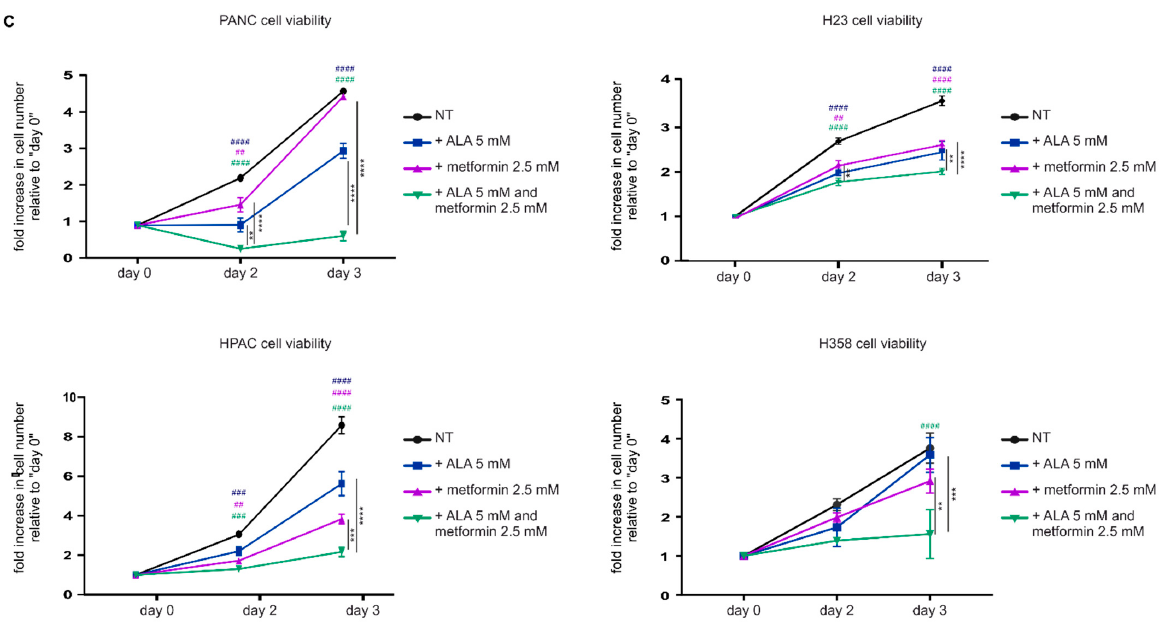
Figure 3. The down-modulation of the heme synthesis-export system sensitizes pancreatic and lung cancer cells to metformin. ( A ) Western blot analysis of FLVCR1a expression in PANC (on the left ) and H23 (on the right ) cells. Vinculin expression is used as a loading control. Cells in which the expression of FLVCR1a was down-regulated using a specific shRNA are compared to cells expressing a scrambled shRNA. A representative blot is shown. For statistical analyses a Student t - test was used. Densitometry shows mean ± SEM, n = 2 biological replicates, * p < 0.05. ( B ) Cell viability of PANC (on the left ) and H23 (on the right ) cells untreated (NT) or treated with 2.5 mM metformin, measured after two days of drug exposure without medium refresh. Cells in which FLVCR1a expression was down-modulated using a specific shRNA are compared to cells expressing a scramble shRNA. Cell viability is measured as a fold increase over an untreated calibrator sample and expressed relative to day 0. For statistical analyses, a two-way analysis of variance was performed, followed by the Bonferroni correction for multiple groups comparisons. Values represent mean ± SEM, n = 4 biological replicates, ** p < 0.01, *** p < 0.001. ( C ) Cell viability of PANC, HPAC H23 and H358 cells measured at different time points as a readout of cell proliferation. Untreated (NT) cells are compared to cells treated with ALA, metformin or ALA + metformin. Drug administration occurred at day 1 of cell proliferation. Cell viability of PANC, HPAC, and H23 was measured with Cell Titer- Fluor™ Cell Viability Assay as a fold increase over an untreated calibrator sample and expressed relative to day 0. Data represent mean SEM, n = 4 biological replicates. H358 cell proliferation was ± assessed with a manual count, data represent mean SEM, n = 2 biological replicates. For statistical ± analyses, a two-way analysis of variance was performed, followed by the Bonferroni correction for multiple groups comparisons; * symbols are used to indicate statistical significance when cells treated with ALA + metformin are compared to cells treated with metformin or ALA alone; # symbols are used to indicate statistical significance when treated cells are compared to untreated cells; ** or ## p < 0.01, *** or ### p < 0.001, **** or #### p <